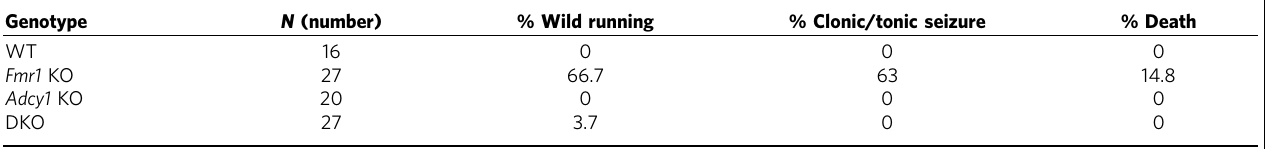
Table 1 | Genetic deletion of Adcy1 attenuates audiogenic seizures.